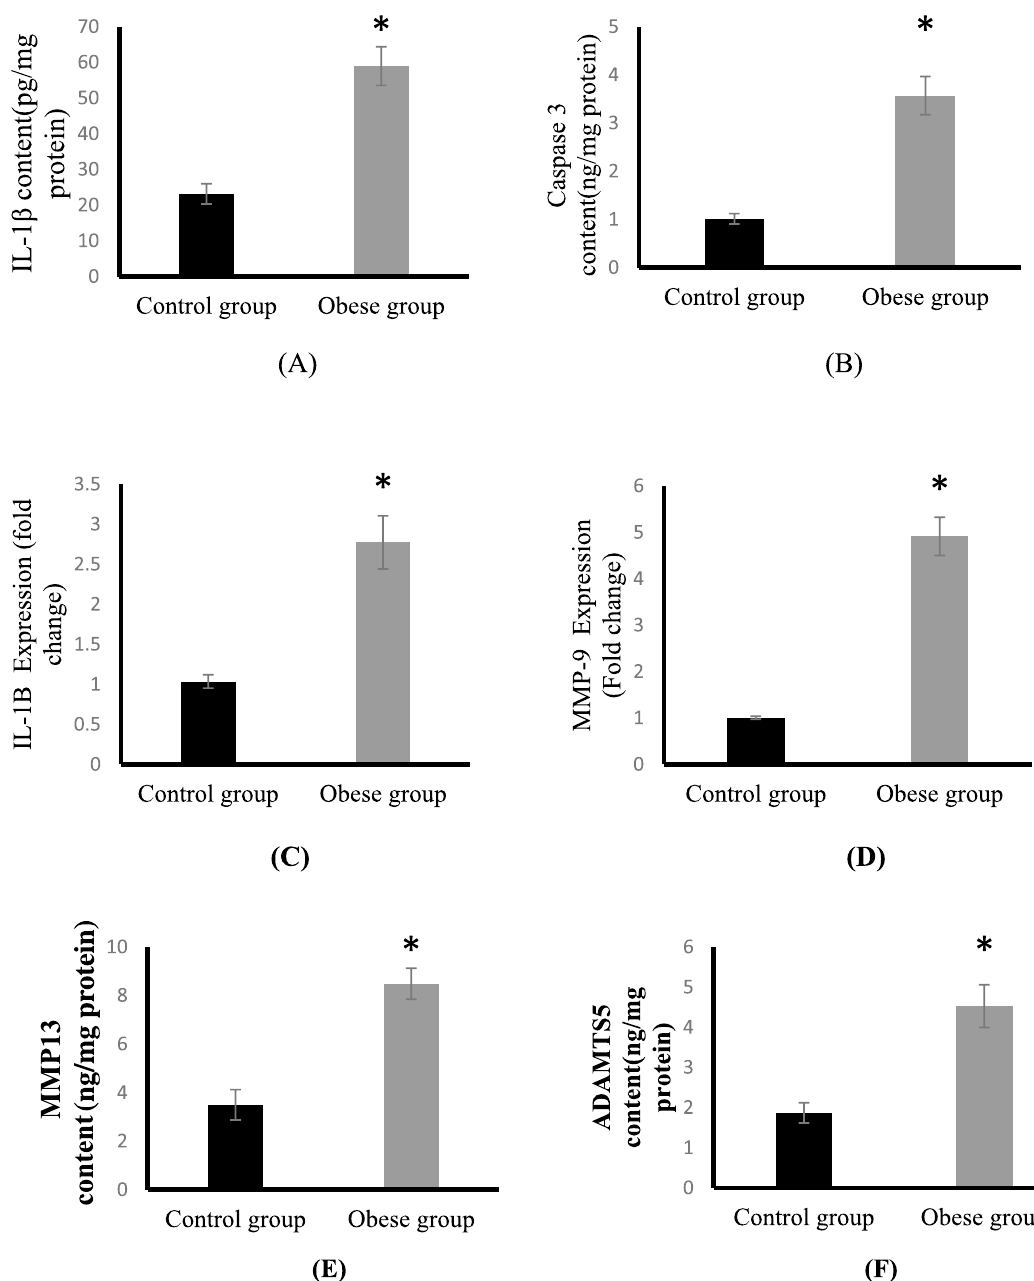
Figure 3. Cartilage mRNA expressions of IL-1β (pg/mg protein) ( A ) and caspase 3 (ng/mg protein) ( B ) IL-1β expression ( C ) and MMP-9 expression ( D ), MMP13 (ng/mg protein) ( E ) and ADAMTS5 (ng/mg protein) ( F ) in the control and obese